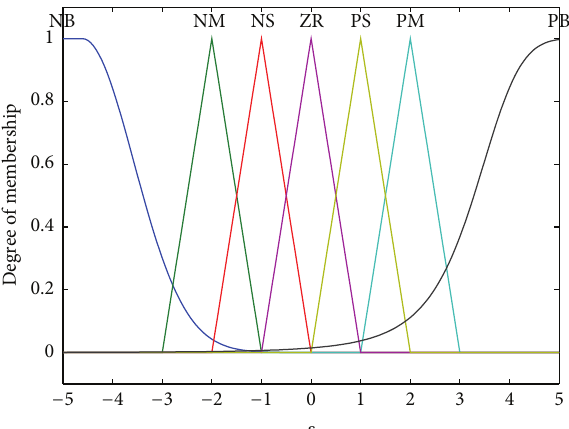
Figure 17: Membership function of fuzzy output 𝜀